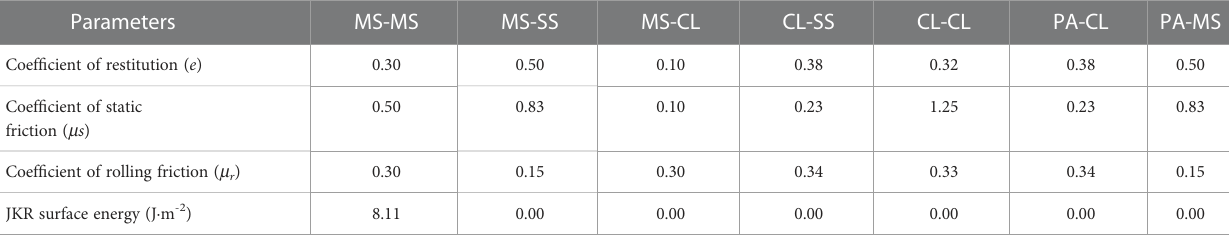
(Table 3). And two linear reciprocating motions (frequency: 15 Hz, Reciprocal motion displacement: 20 mm, amplitude in Table 3) were added to the double-layer vibrating screen, the